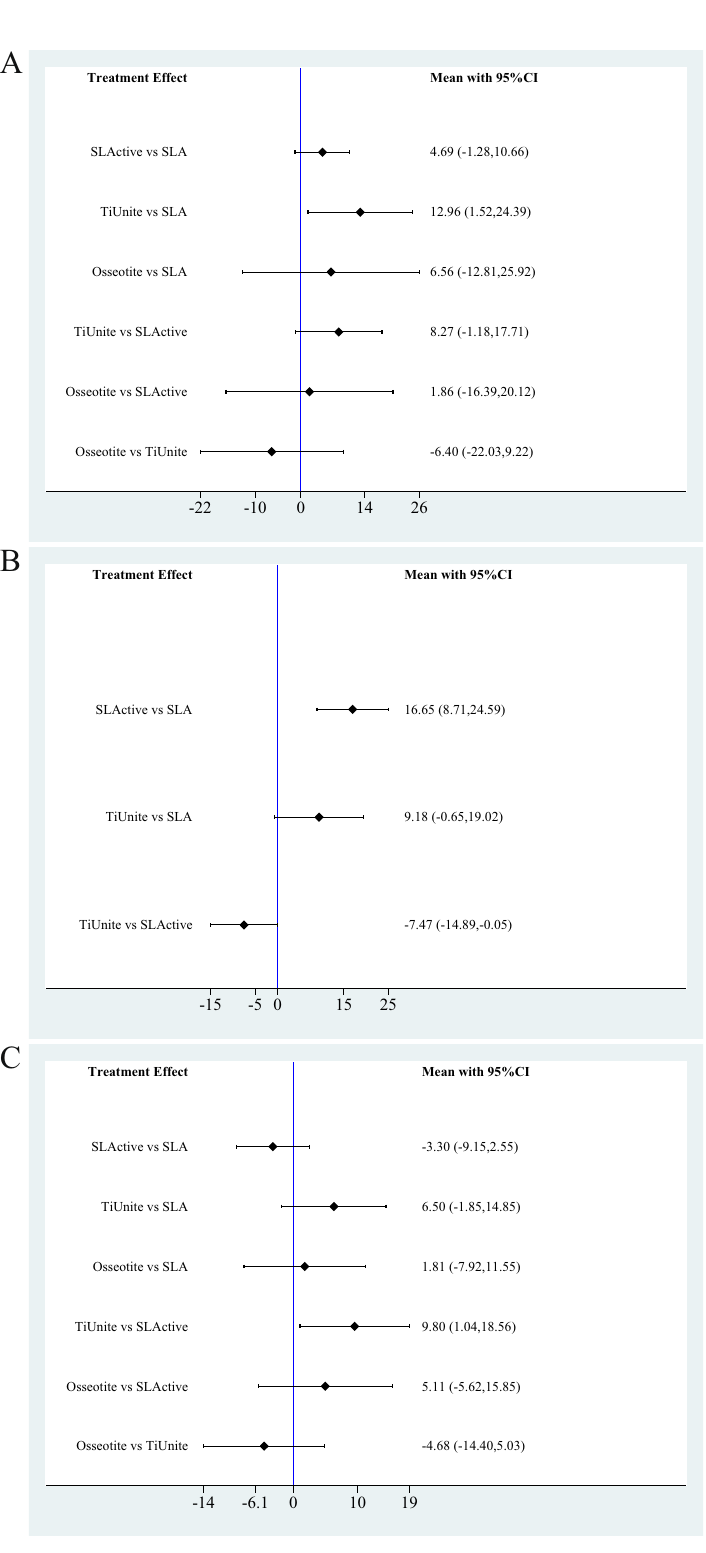
Figure 3. Forest plot of four titanium implant surfaces. ( A ) BIC value of final healing stage; ( B ) BIC value of early healing stage; ( C ) ISQ value of final healing